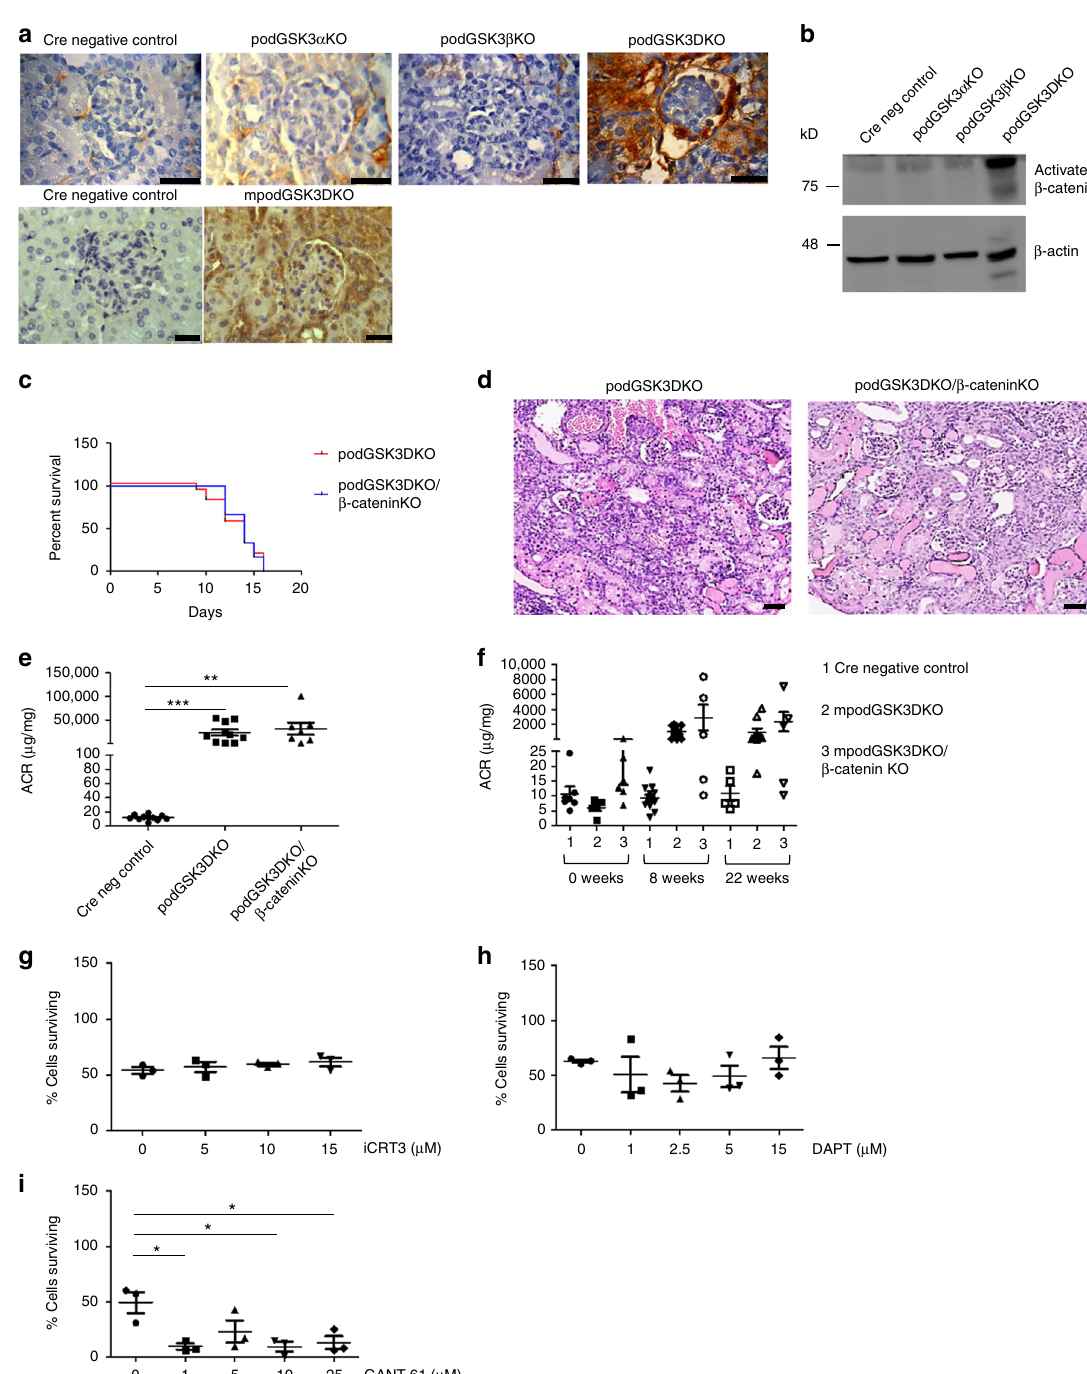
Fig. 4 Podocyte GSK3 loss activates Wnt- β -catenin but this is not responsible for pathology. a β -catenin is expressed in podocytes and throughout the kidney in podGSK3DKO and mpodGSK3DKO mice but not in single isoform podocyte-speci fi c knockout mice. Representative IHC pictures, scale bar = 25 μ m. b Western blot of kidney lysates shows increased activated β -catenin in podGSK3DKO mice but not in control and single isoform podocyte-speci fi c knockout mice, n = 3 experiments. See also Supplementary Fig. 5a. ( c ) No difference in survival of the podGSK3DKO/ β -catenin KO compared to the podGSK3DKO mice. (Kaplan – Meier survival curve. Log-rank (Mantel-Cox test non-signi fi cant) podGSK3DKO n = 14; podGSK3DKO/ β -catenin KO n = 12 mice. d No difference in the histological appearance of the podGSK3DKO/ β -cateninKO compared to the podGSK3DKO mice at day 10 of life. Representative images of PAS staining, scale bar = 25 μ m. e No difference in the level of albuminuria in podGSK3DKO/ β -cateninKO compared to the podGSK3DKO mice. (Cre negative control n = 10; podGSK3DKO n = 10; podGSK3DKO/ β -catenin KO n = 7 mice. Kruskel Wallis test not signi fi cant). f No difference in the level of albuminuria in mpodGSK3DKO/ β -cateninKO compared to the mpodGSK3DKO mice, n = 5 – 7. g Inhibiting the Wnt pathway has no effect on cipodGSK3DKO cell survival ( n = 3 experiments). h Inhibiting the Notch pathway has no effect on cipodGSK3DKO cell survival ( n = 3 experiments). i Inhibiting the Hedgehog pathway in cipodGSK3DKO cells increases cell death (unpaired two-tailed t test * p < 0.05, n = 3